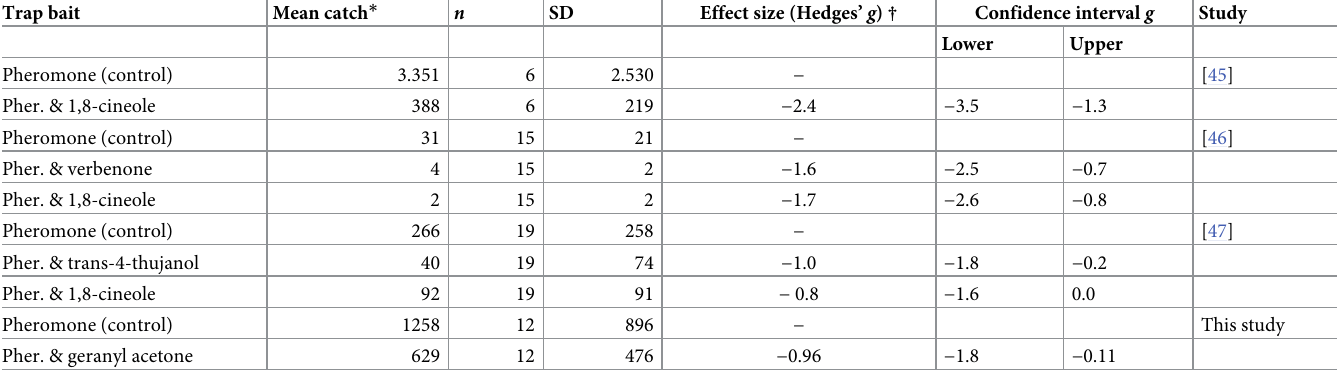
Table 3. Effect sizes of anti-attractants trapping Ips typographus in three trapping studies for the addition of geranyl acetone compared to other host-derived anti- attractants to aggregation pheromone alone (control). Trap